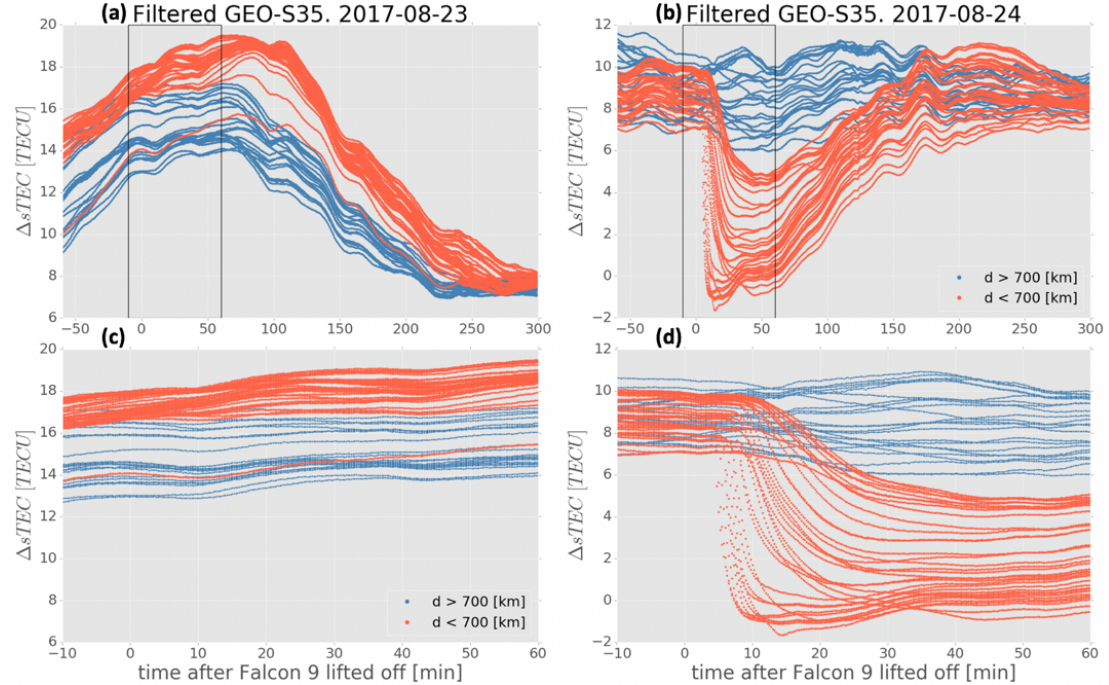
Figure 4. Filtered VARION-GEO ∆ sTEC results for satellite S35. Day before ( left column ) and day of the event ( right column ). The first row ( a , b ) represents the solutions far from the ionospheric hole ( blue curves ) and close to the ionospheric hole ( red curves ). Time zero represents the time of the Falcon 9 launch (11:51 PDT). The second row ( c , d ) is a zoom in 10 min before to 60 min after the launch. The ionospheric depletion is clearly captured by the filtered VARION-GEO solutions near the ionospheric hole for the day. No depletion is showed either the day before or far from the